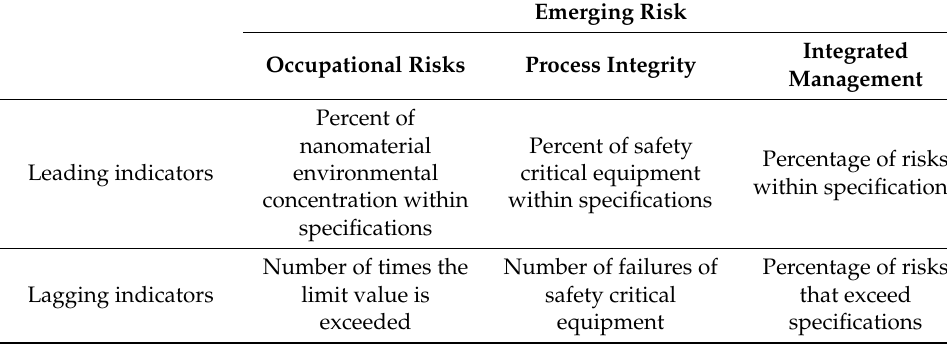
Table 6. Case study (Own